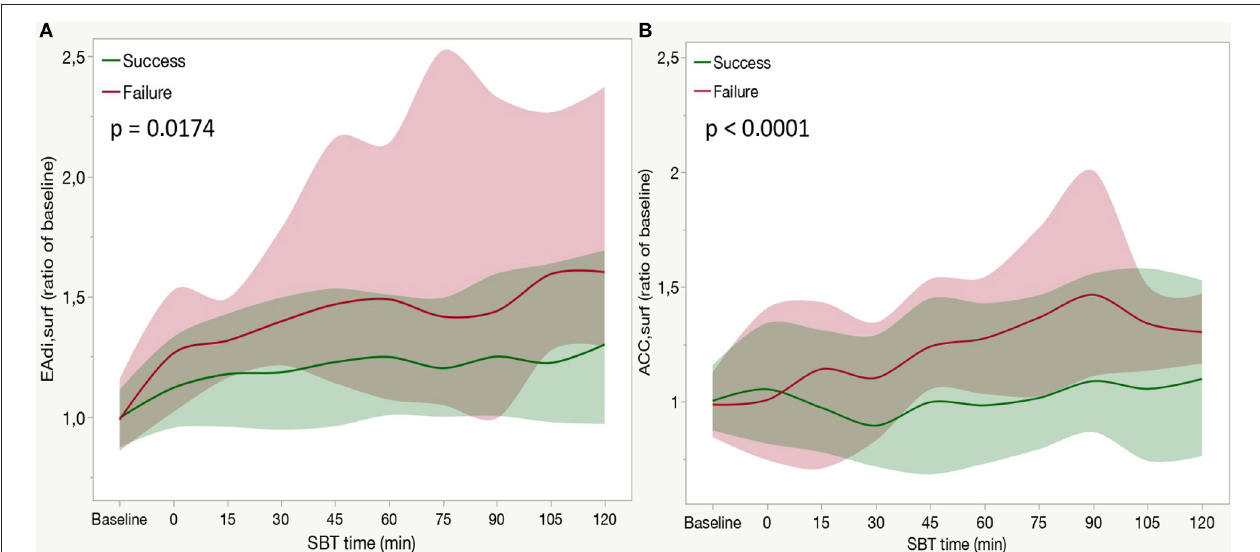
FIGURE 2 | Time course of the diaphragm electrical activity [EADI surf (A) ] accessory muscle electrical activity [ACC surf , (B) ] during a spontaneous breathing trial (SBT) in weaning failure (red line) or success (green line) patients. Each line indicates the median value at each time point with bands indicating interquartile range (IQR). A P -value refers to the between-group comparison performed with the use of the two-factor analysis of variance to test time (from baseline to 120min of SBT) and group effects (SBT failure or success). In a post-hoc analysis median EAdi surf at each time point was higher than baseline ( p < 0.05) both in the failure and success group. In a post-hoc analysis median ACC surf was higher than baseline in the success group at 75 ( p = 0.0093), 90 ( p < 0.0001), 105 ( p < 0.0001), and 120min ( p < 0.0001) and at 75 ( p = 0.0003), 90 ( p < 0.0001), and 105min ( p < 0.0035) in the failure